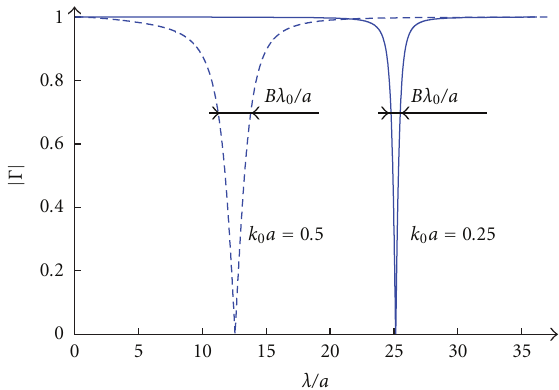
Figure 1: The reflection coe ffi cient of the idealized dipole antenna (4) for k 0 a = 1 / 2 and k 0 a = 1 / 4 with C = (cid:2) 0 a , L = μ 0 a and R 1 = η 0 as function of the normalized wavelength λ/a = 2 πc 0 / ( ωa ).